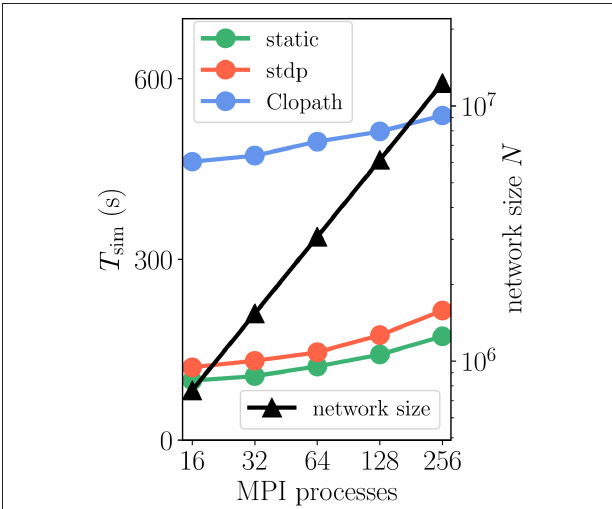
FIGURE 10 | Scaling of simulation time T sim with network size for 2 s of biological time: Clopath plasticity. Weak scaling: computational resources (horizontal axis) increase proportionally to network size N (black curve and triangles, right vertical axis). Event-driven scheme for Clopath rule (blue) compared to static (green) and STDP synapse (red). Network and simulation parameters as in Supplementary Table 5 with in-degree K = 5,000. For all simulations each compute node runs one MPI process with 24